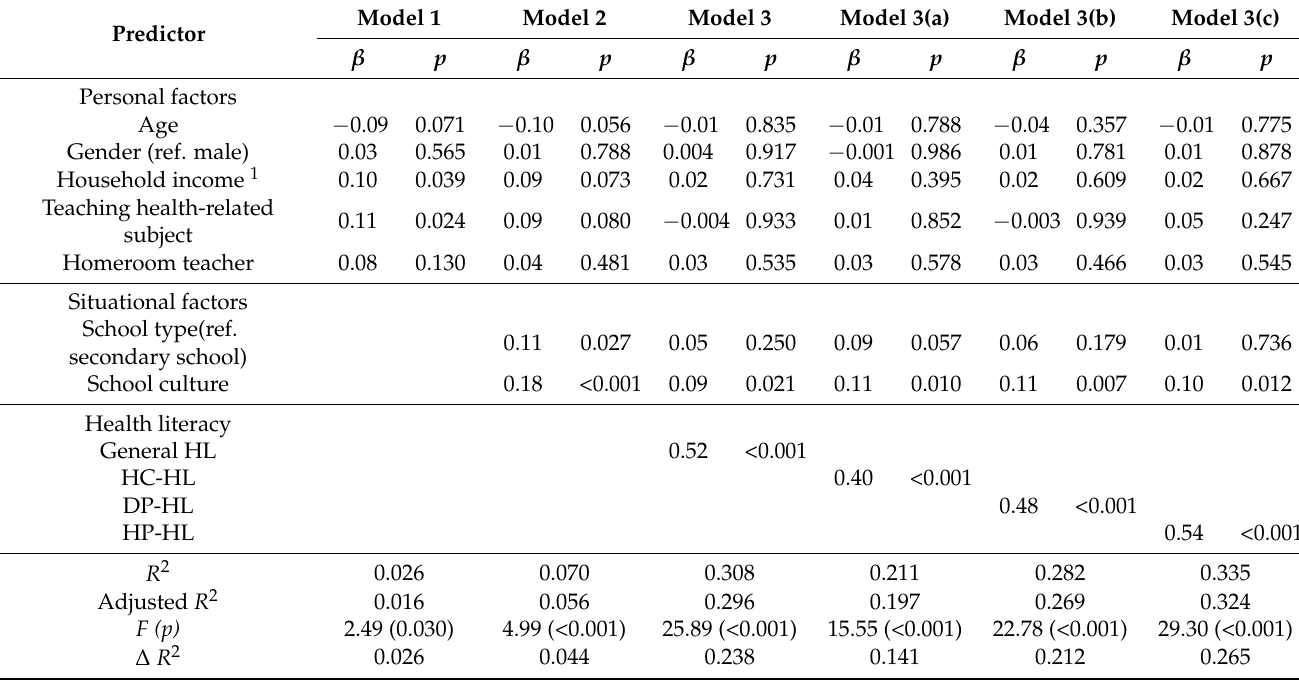
Table 3. Hierarchical multiple regression analysis predicting health-promoting behaviors among teachers.